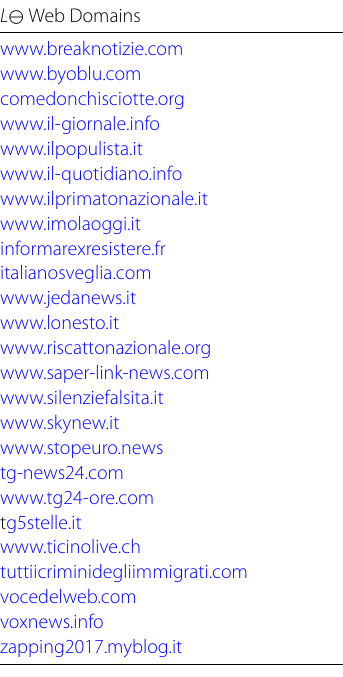
Table 3 List of unreliable media outlets, i.e., online newspaper that have been reportedly considered to contribute spreading mis- and dis-information, according to “ butac.it ” and “ bufale.net